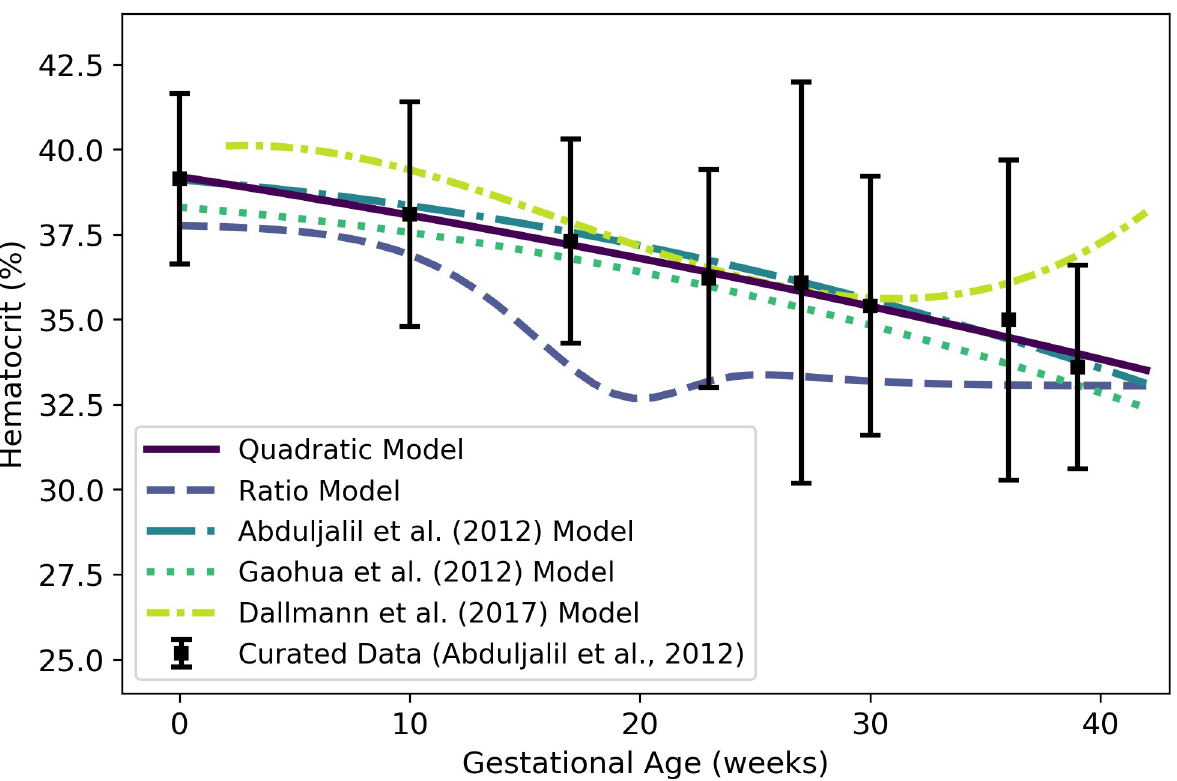
Fig 13. Maternal hematocrit vs. gestational age. The quadratic model (solid line) given by Eq 24 was selected as the most parsimonious model in our analysis. The “ratio model” given by Eq 25 is also shown. The models of Abduljalil et al. [28] and Gaohua et al. [29], both of which are quadratic models, were calibrated using the same curated data set [28] used by us. Dallmann et al. [3] calibrated their model with different data.